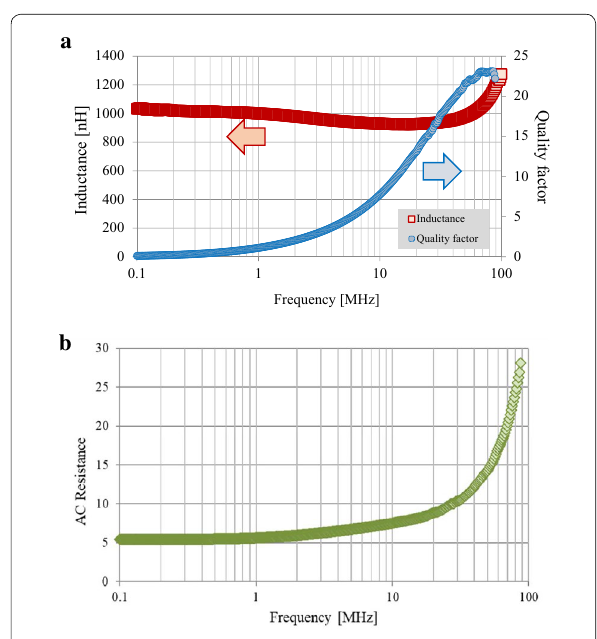
Fig. 10 Characterization results of the 100-turn toroid inductor: inductance, low-frequency resistance, and quality factor